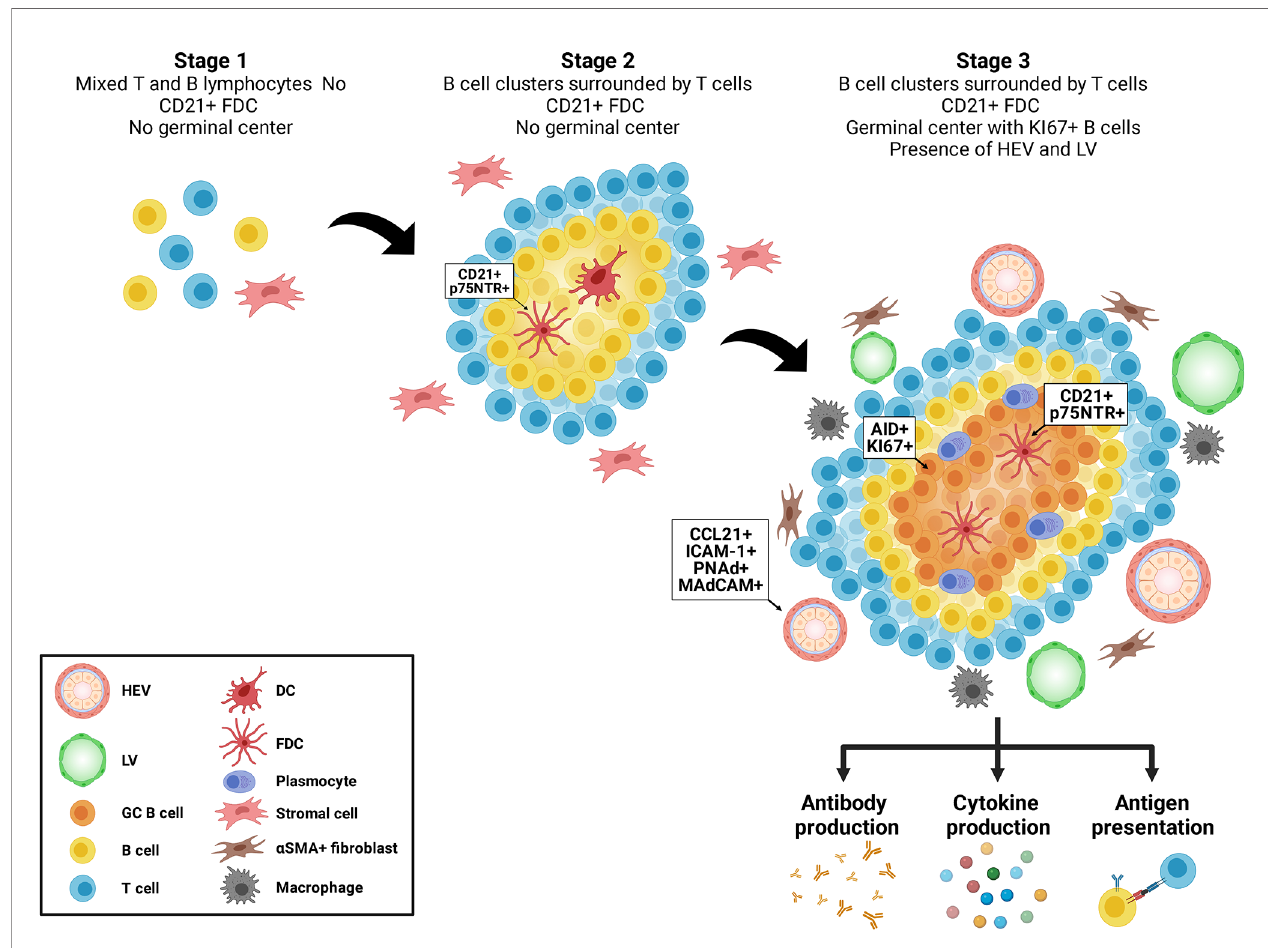
FIGURE 1 | Maturation of tertiary lymphoid structures. Tertiary lymphoid structures evolve from loose aggregates of T and B cells and stromal cells (Stage 1), to polarized clusters of T and B cells accompanied by follicular dendritic cells (FDC) (Stage 2) to mature polarized structures containing germinal centers, proliferating B cells, plasma cells, high endothelial venules (HEV) and lymphoid vessels